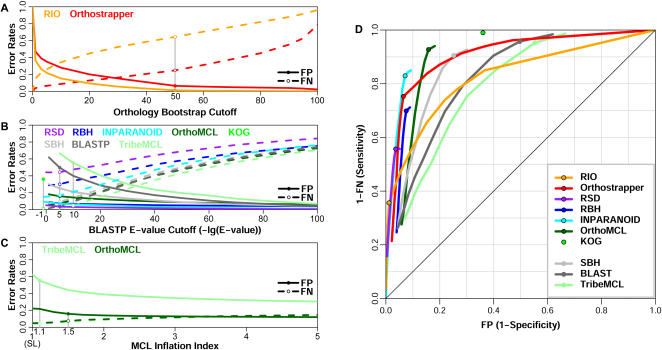
The effects of parameter alteration on orthology detection performance.
Panel A: Phylogeny-based methods. Varying the orthology bootstrap cutoff indicates that the cross-over point where FP = FN occurs at a lower cutoff than the suggested default (50%; gray bar). Panel B: BLAST-based methods. The effect of changing E-value cutoff for various methods (the bit score cutoff used by Inparanoid is transformed into E-value cutoff) is shown. Single data point is provided for KOG, which could not be readily rerun under diverse conditions. Panel C: Markov clustering methods. The effect of varying the MCL inflation index is shown. The inflation index of 1 corresponds to single-linkage (SL) clustering. In panels A–C, FP and FN error rates are represented by solid and dashed lines, respectively. Panel D: An ROC curve representing the range of FP and FN error rates observed in panels A & B. Default or recommended settings for each method are indicated by circles.